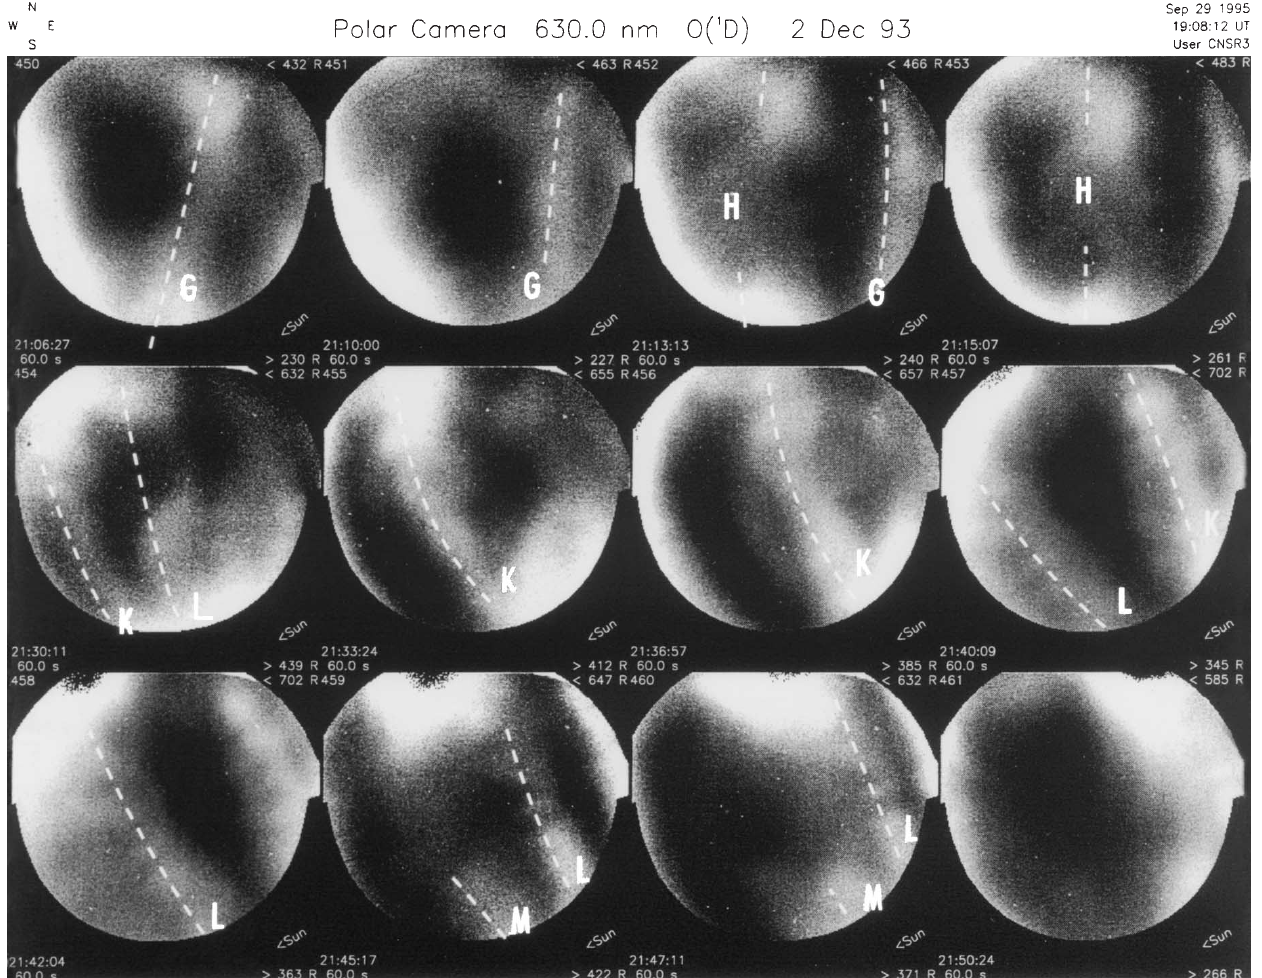
Fig. 18. The 630-nm emission images from the polar camera in Eureka showing patches/bands associated with CADI and SuperDARN